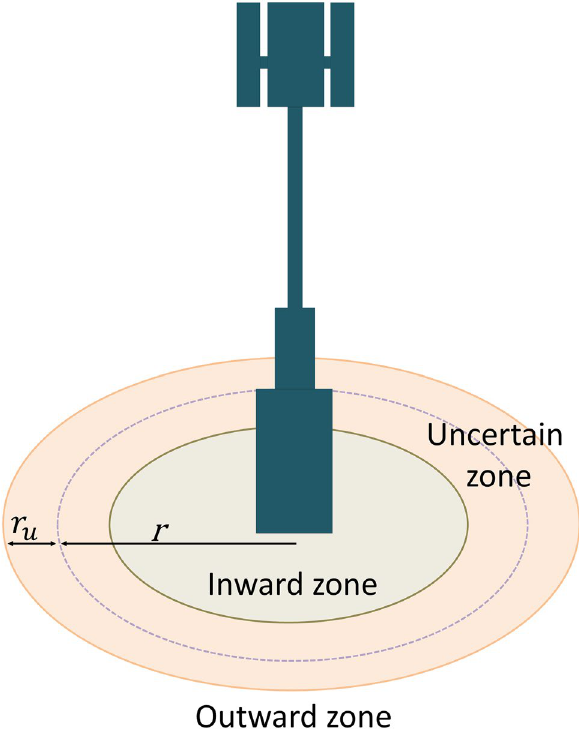
Figure 4. The probabilistic sensing model.